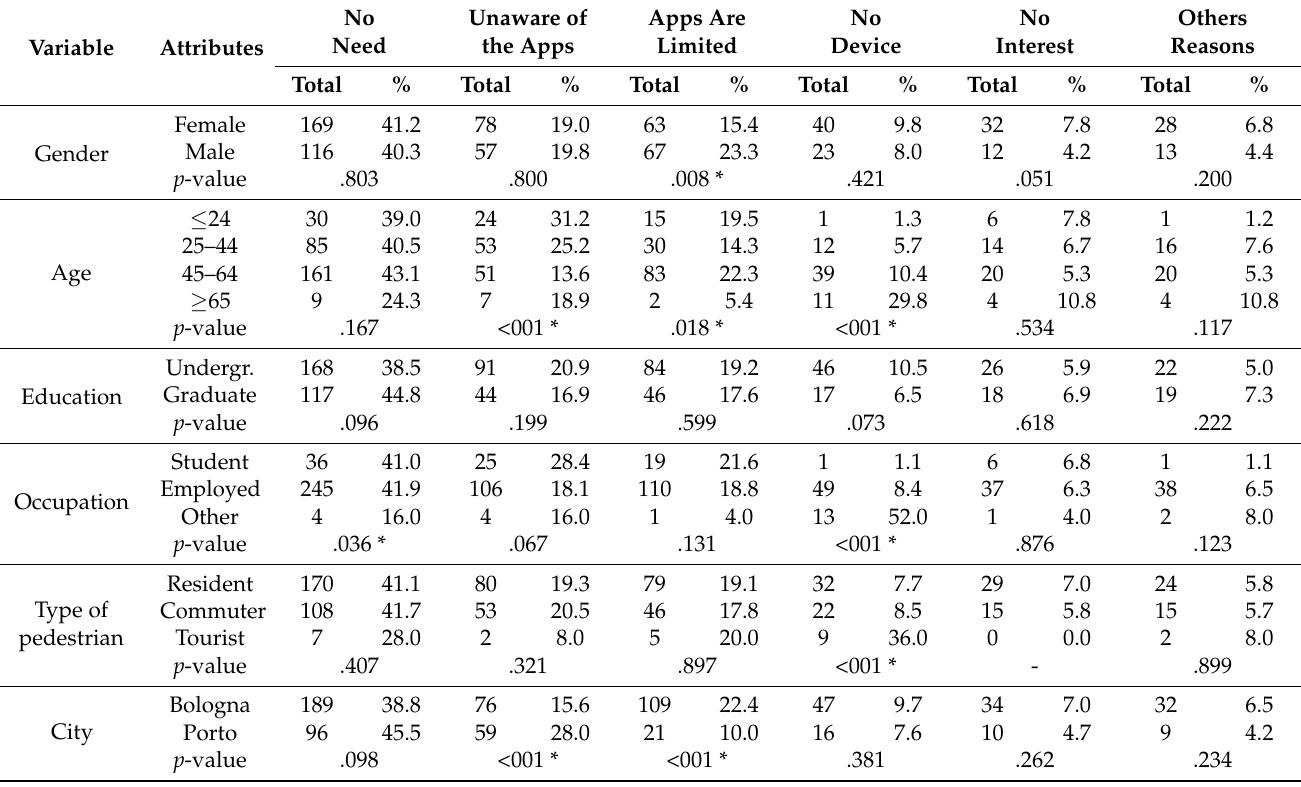
Table 4. Main barriers preventing the use of pedestrian navigation apps ( N =